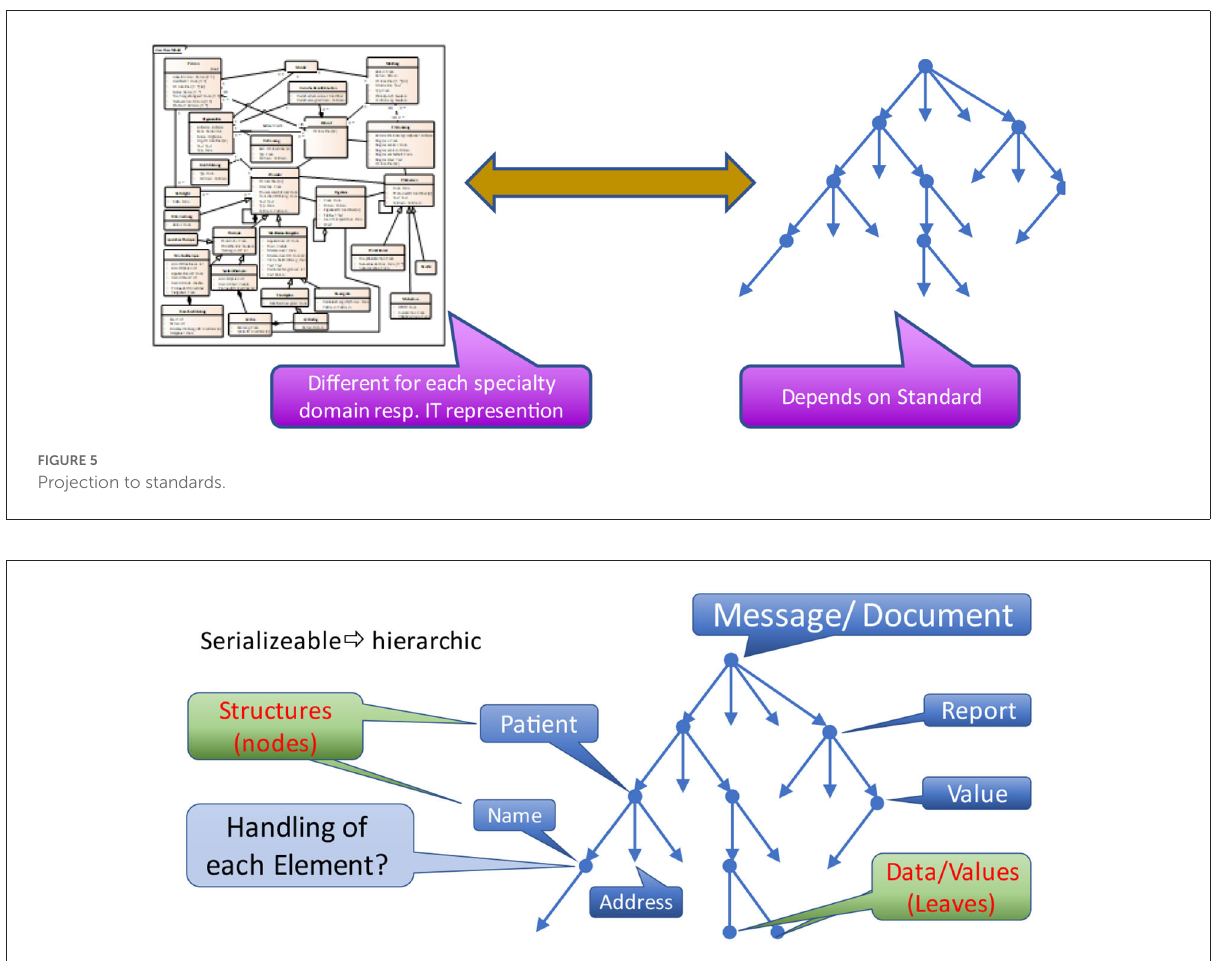
FIGURE6 Hierarchic data